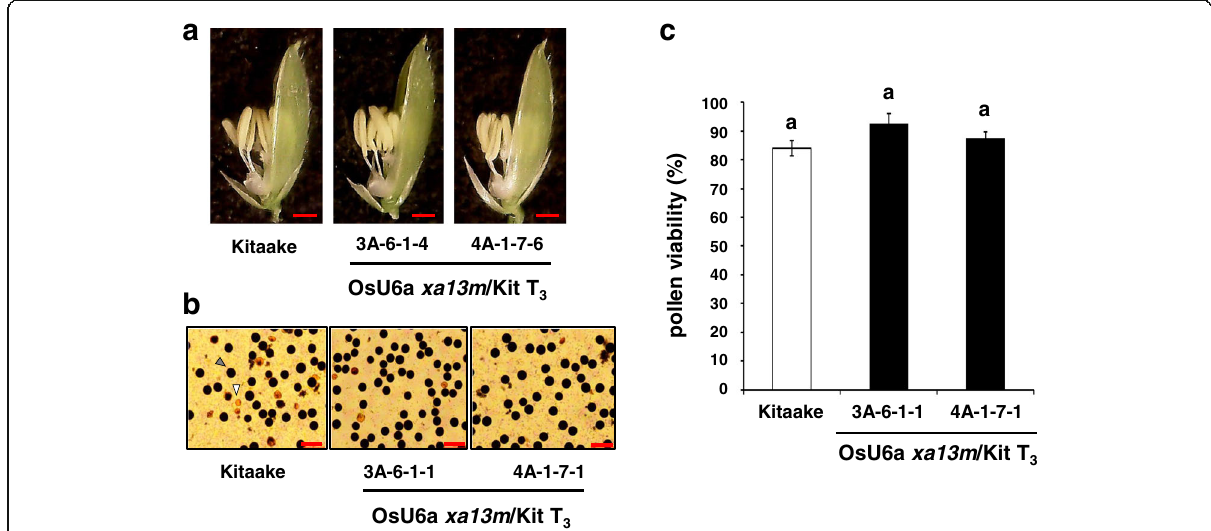
Fig. 6 Pollen viability of the homozygous xa13 mutants. a Anthers in mature spikelets of Kitaake, homozygous mutant (T 3 , 3A-6-1-4), and homozygous mutant (T 3 , 4A-1-7-6). Scale bars, 1 mm. b Representative images of pollen viability tests from Kitaake and homozygous mutants (T 3 , 3A-6-1-1 and 4A-1-7-1). Viable pollen grains are stained dark (gray arrow) and sterile pollen grains are stained light yellow (white arrow). Scale bars, 100 μ m. c Statistical analysis of pollen viability of Kitaake, homozygous mutants (T 3 , 3A-6-1-1 and 4A-1-7-1) lines. Pollen viability percentage was calculated relative to the total pollen counted in three microscopic